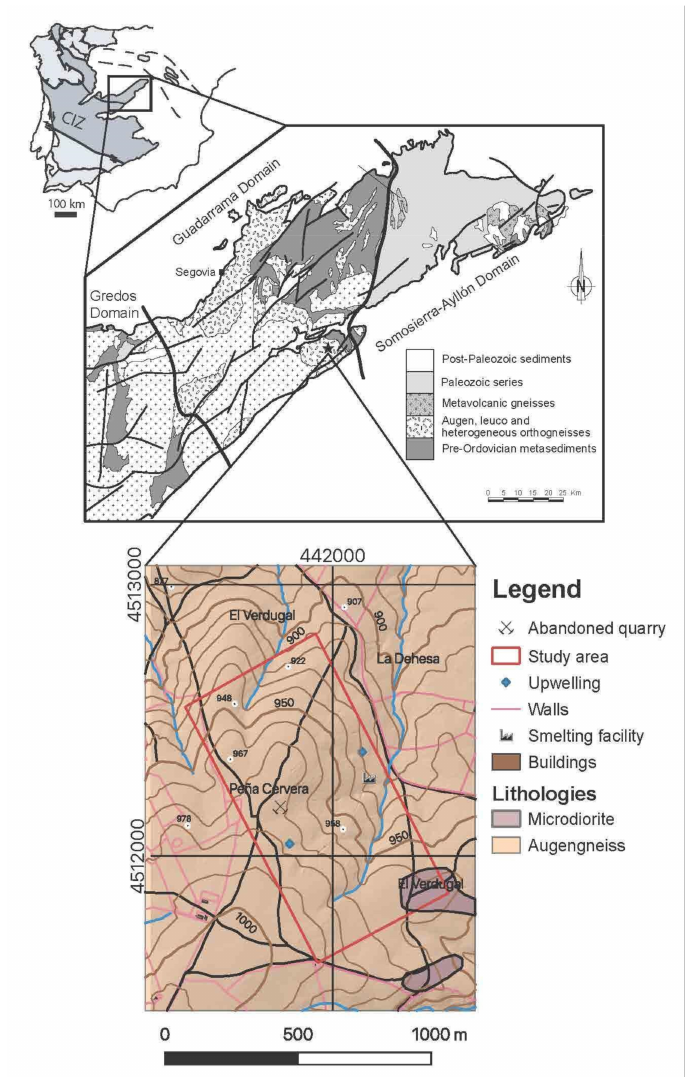
Figure 1. Geological sketch of the Spanish Central System (modified from [14] with the location of the study area and its geological map [15]. The coordinate system is ETRS89 / UTM zone 30N (N-E). The position of the Central Iberian Zone (CIZ) in the Iberian Massif is shown in the upper part of the